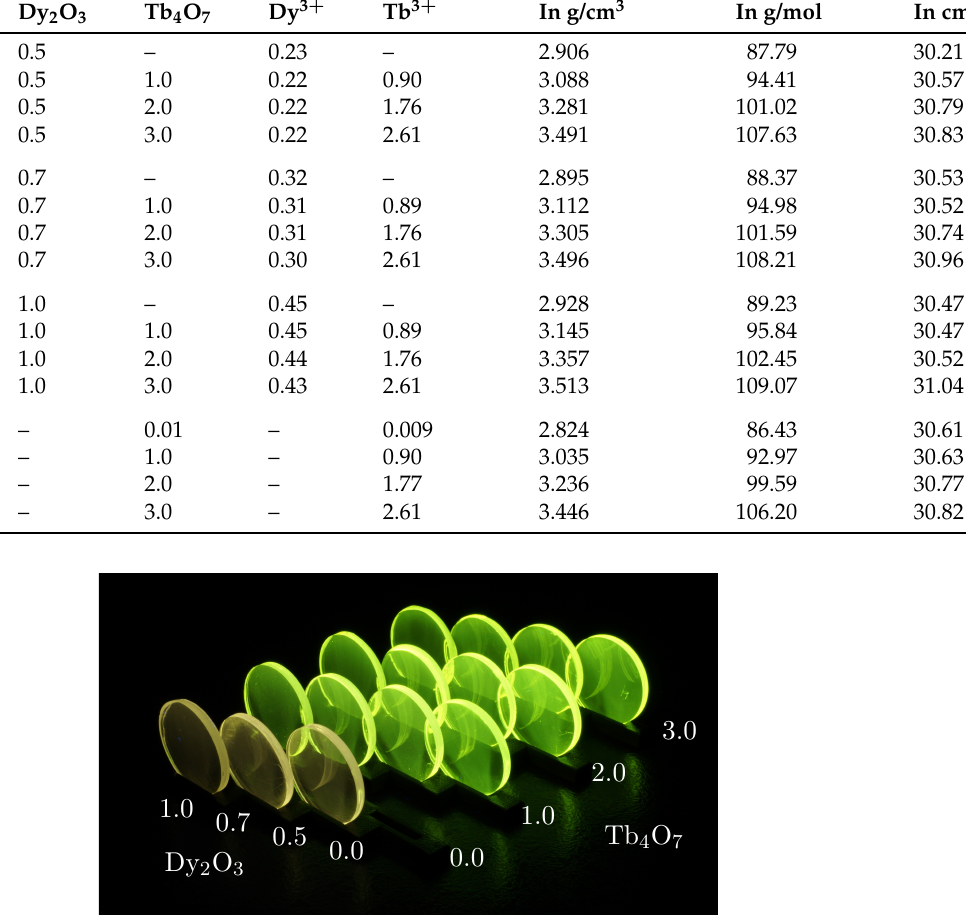
Figure 1. Sample series of Dy 3 + and Tb 3 + single- and double-doped BaB glasses with different Dy 3 + and Tb 3 + contents under 365 nm excitation. From left to right, the Dy 2 O 3 content is 1.0, 0.7, 0.5, and 0.0; from front to back, the Tb 4 O 7 content amounts to 0.0, 1.0, 2.0, and 3.0 (all values are in